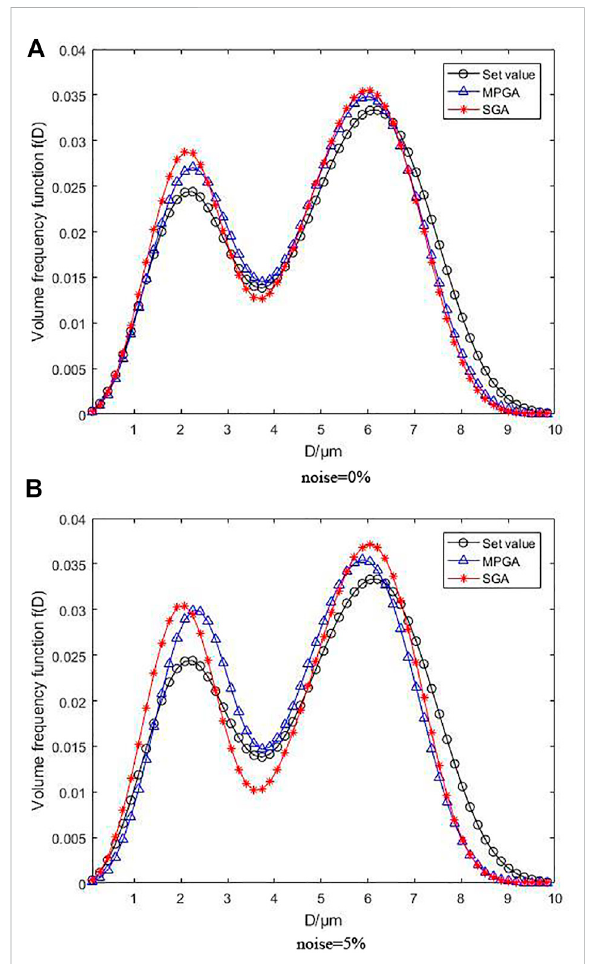
FIGURE 7 Inversion results following bimodal distribution with different algorithms.